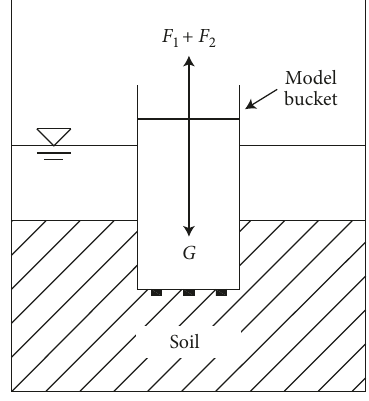
Figure 3: Schematic diagram of static balance in vertical